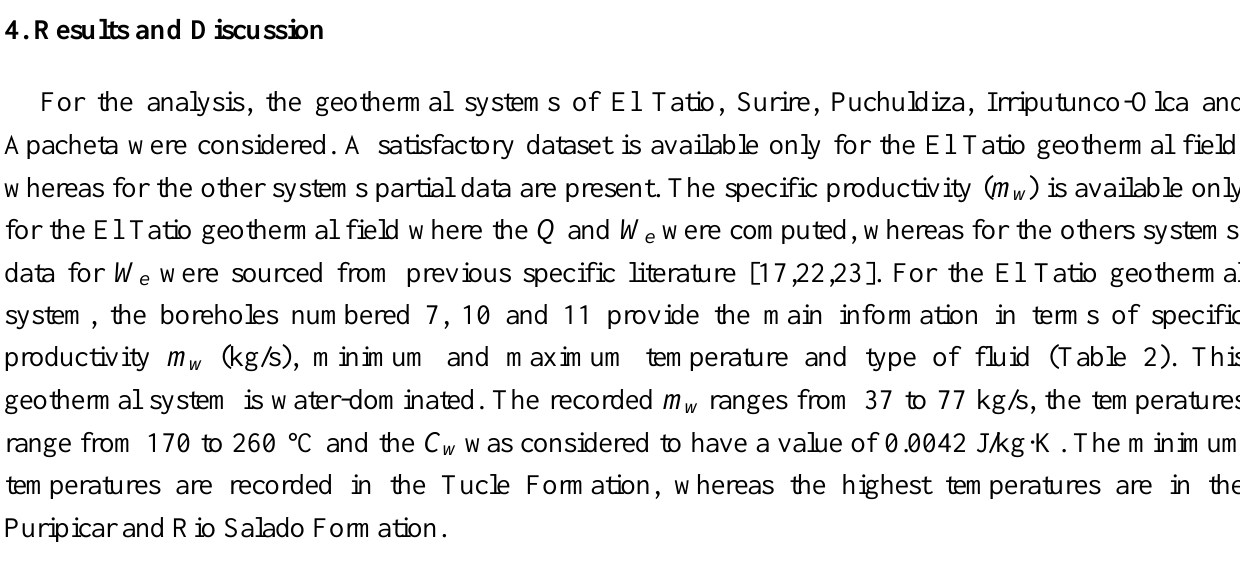
Table 2. Available data for the El Tatio geothermal